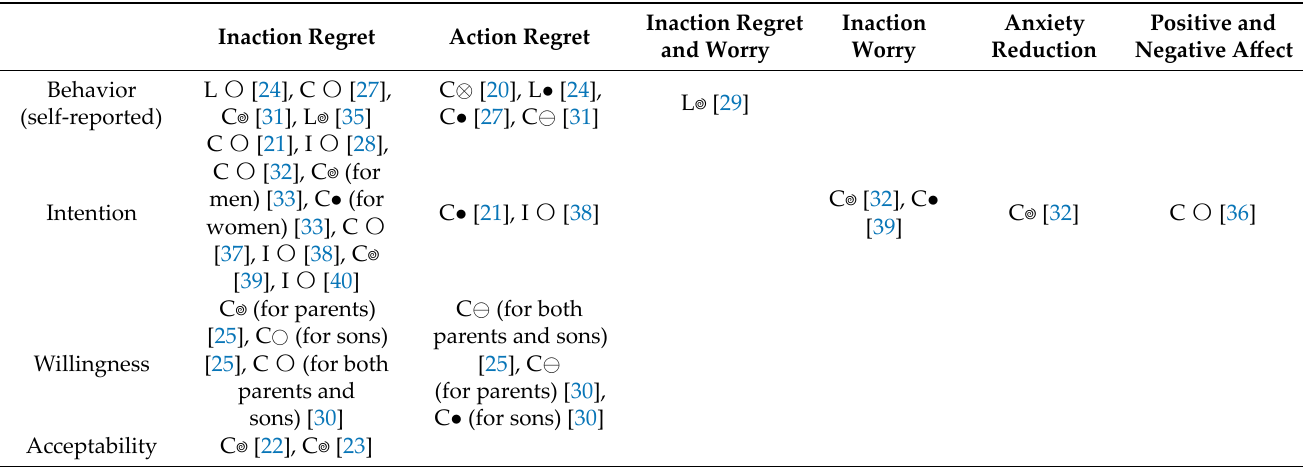
Table 2. Summary of key findings of quantitative studies based on the type of anticipated affect and primary outcome